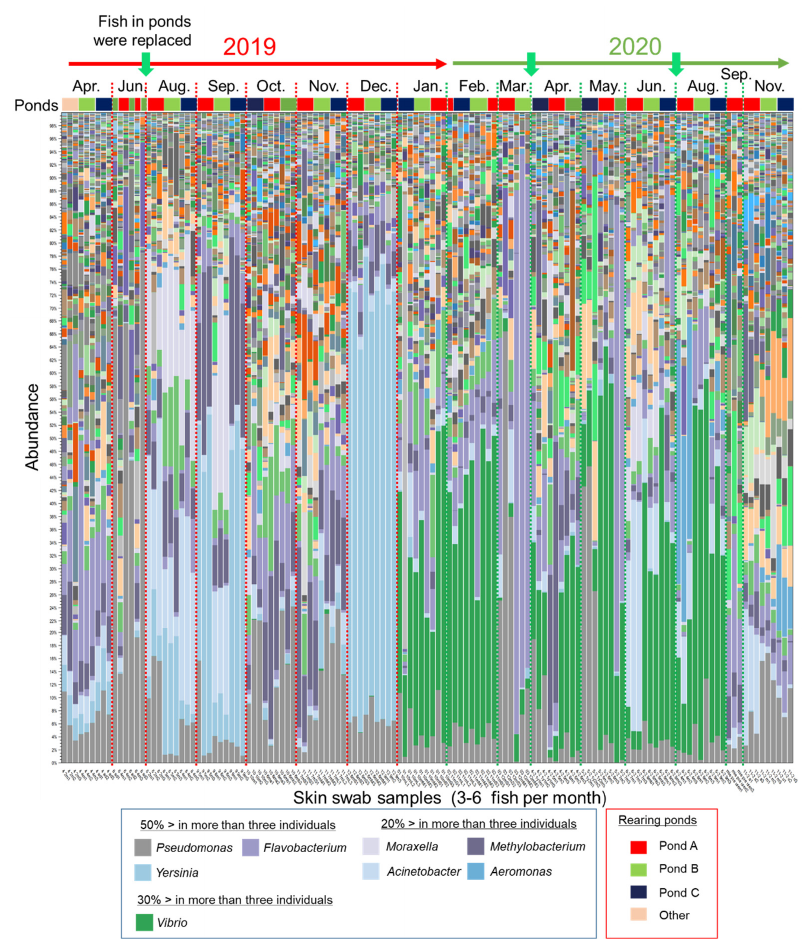
Figure 1. Bacterial composition in the epidermal mucus of rainbow trout reared in a flow-through aquaculture pond. The stacked bar chart shows the composition and abundance of operational tax- onomic units (OTUs) (top-100, at the genus level) in epidermal mucus samples. The samples were collected every 1 to 2 months in 2019 and 2020. Green arrows indicate when all the fish in the ponds (Ponds A, B, and C) were replaced. The more abundant bacterial genera (e.g., >50% in more than three individual fish) are indicated in the figure legend.